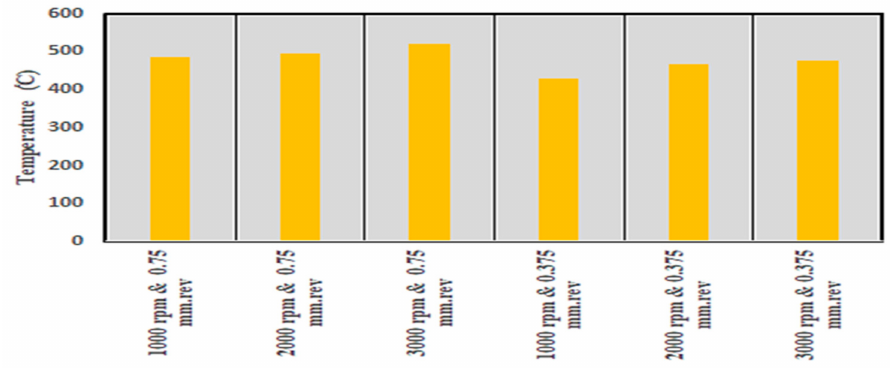
Figure 10. Average cutting temperature values observed for the six simulations of Table 4.